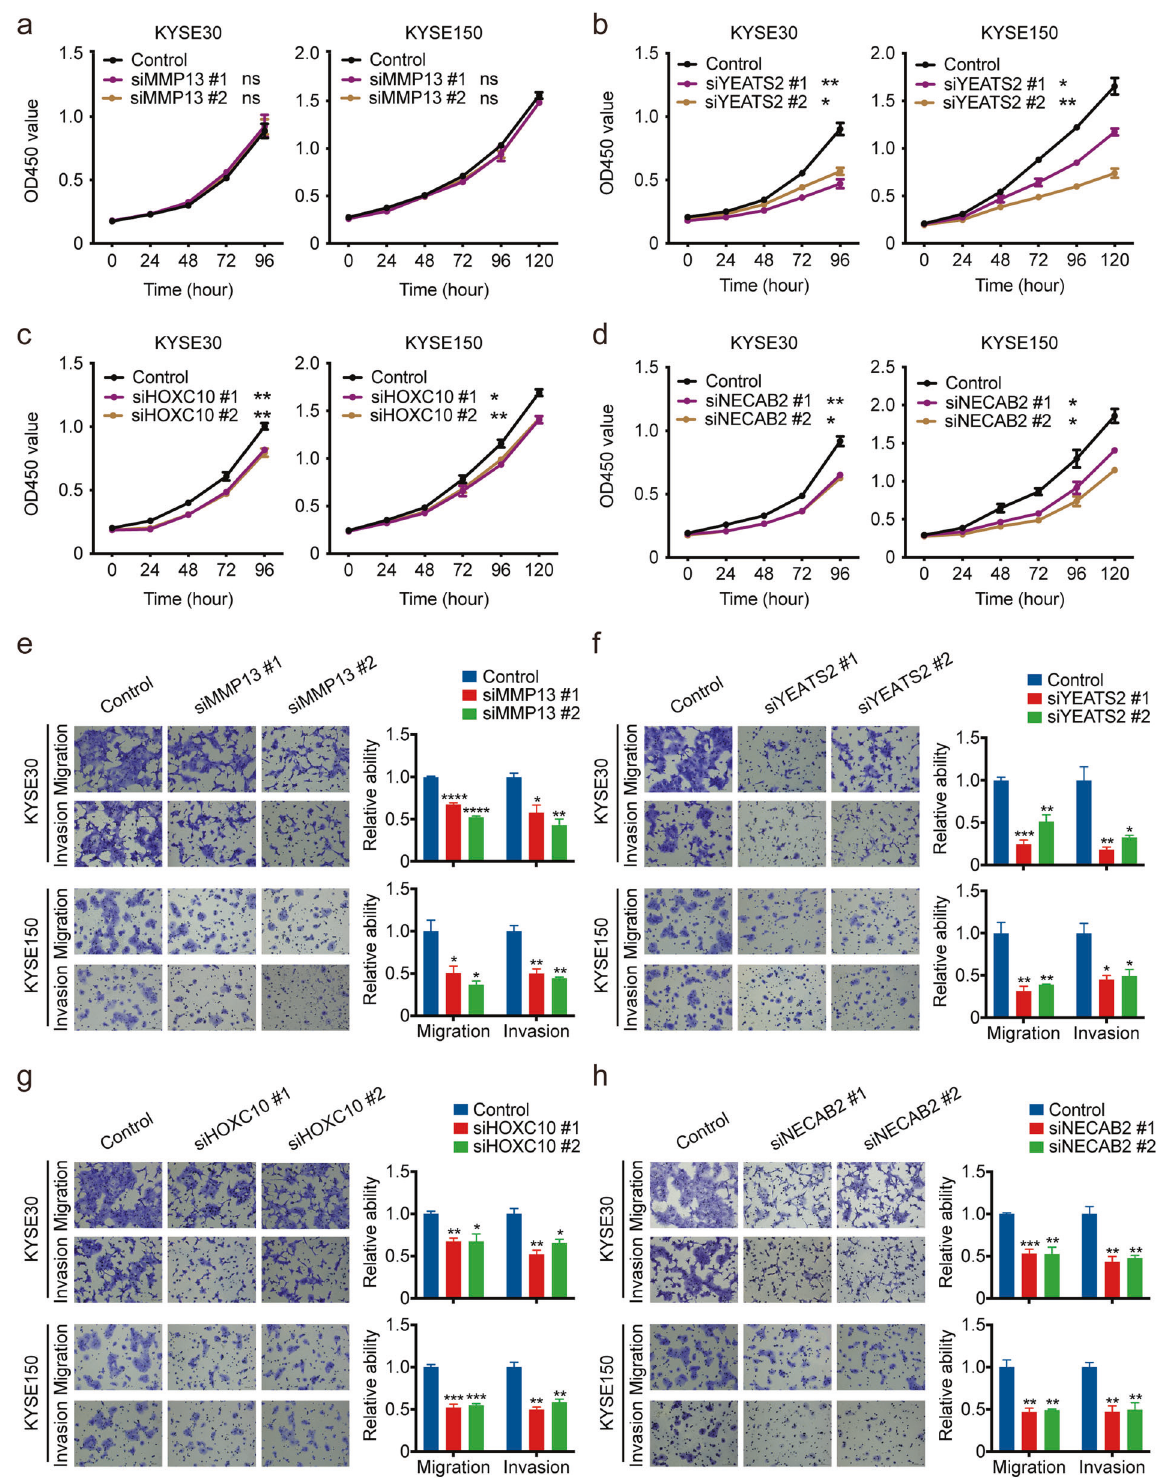
Fig. 6 Effects of silencing some genes in diagnostic and prognostic panels on ESCC cell phenotypes. a – d Silencing the expression of MMP13 ( a ), YEATS2 ( b ), HOXC10 ( c ) and NECAB2 ( d ) signi fi cantly suppressed KYSE30 and KYSE150 cell proliferation. e – h Silencing the expression of MMP13 ( e ), YEATS2 ( f ), HOXC10 ( g ) and NECAB2 ( h ) signi fi cantly suppressed KYSE30 and KYSE150 cell migration and invasion. Left panel shows representative cell migration and invasion images and right panel shows quanti fi cation statistics. Data represent mean ± SEM from 3 independent experiments. * P < 0.05; ** P < 0.01; *** P < 1.00e-3; **** P < 1.00e-4 and ns not signi fi cant of Student ’ s t test compared with corresponding control